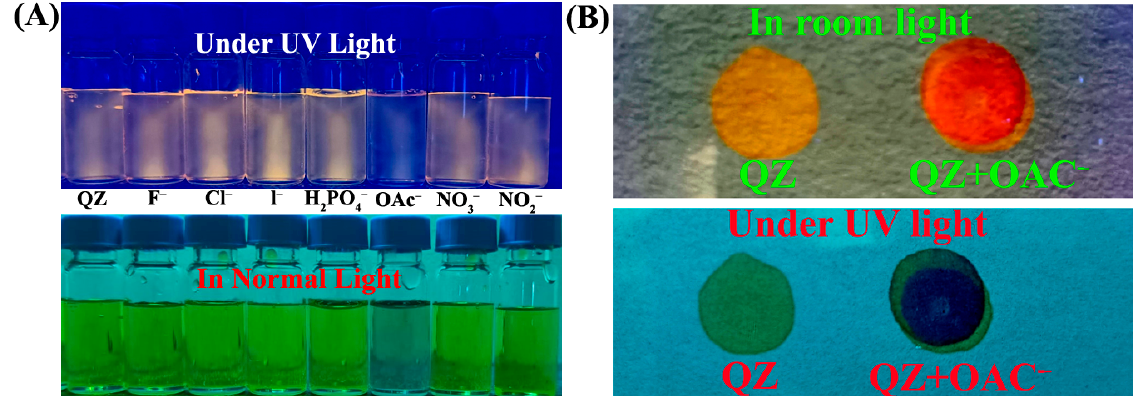
Figure 4. ( A ) The observed visual color changes for QZ in DMSO solution after the addition of different anions. ( B ) The color changes observed for QZ coated on filter paper before and after the mixing of CH 3 COO − anions.